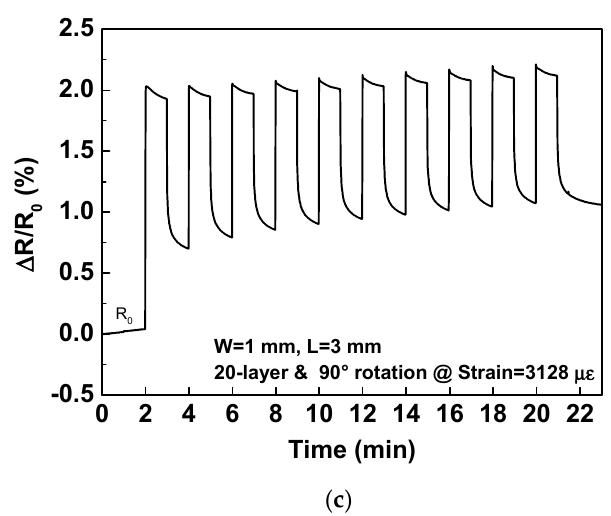
Figure 8. Transient response of the relative resistance change ( ∆ R / R 0 ) for the 20-layer strain sensor under repeated stretching / releasing cycles with tensile strain from 0 to 3128 µε , whereby each strain was held and released for ( a ) 10 s; ( b ) 30 s; ( c ) 60 s.